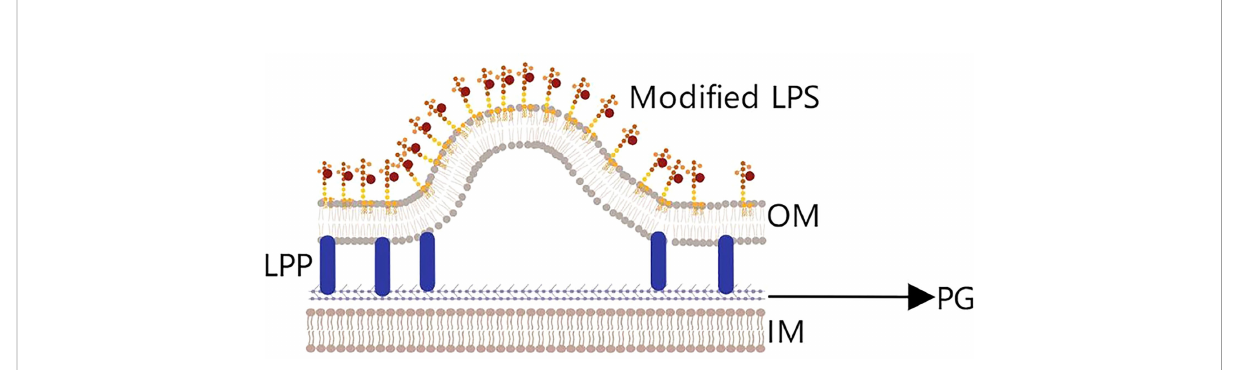
FIGURE 4 The lipid enrichment hypothesis. Adding phospholipids or modifying lipopolysaccharides (LPS) will change the curvature of the outer membrane and cause OMVs to be released. Temperature variation and the level of LPS acylation also impacts the generation of